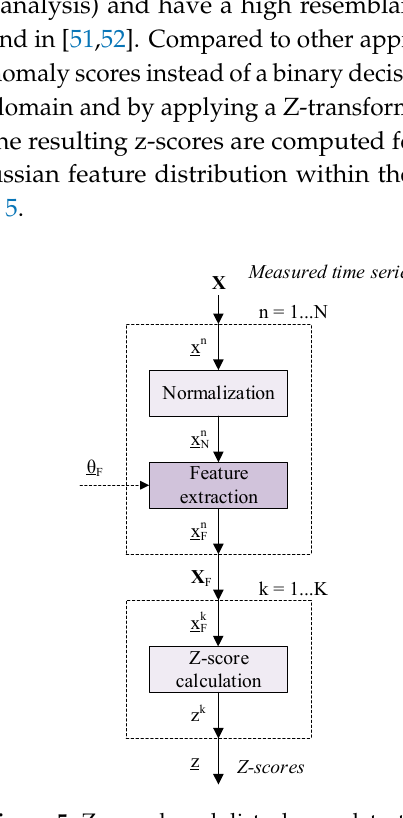
Figure 5. Z-score based disturbance detection model .